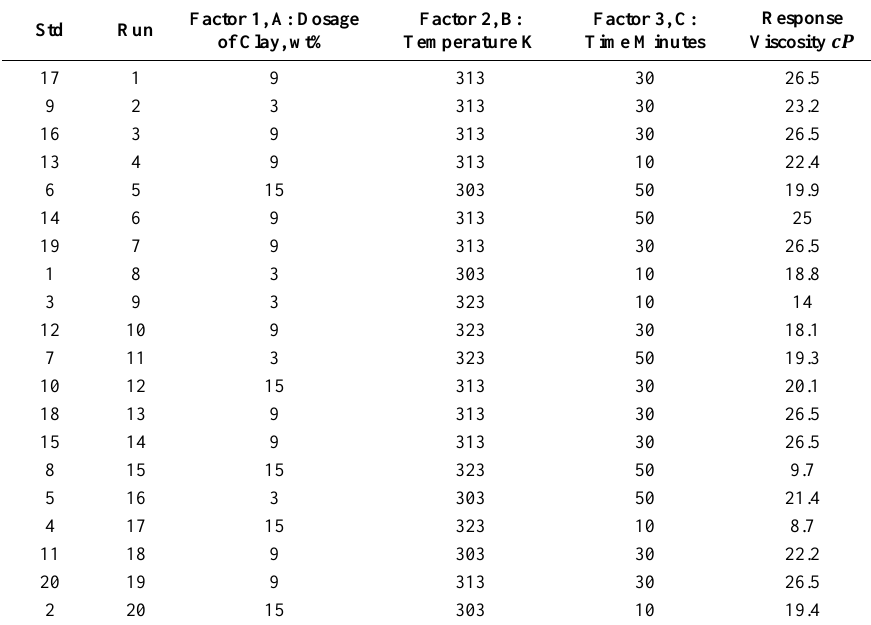
Table 5. RSM results of viscosity of